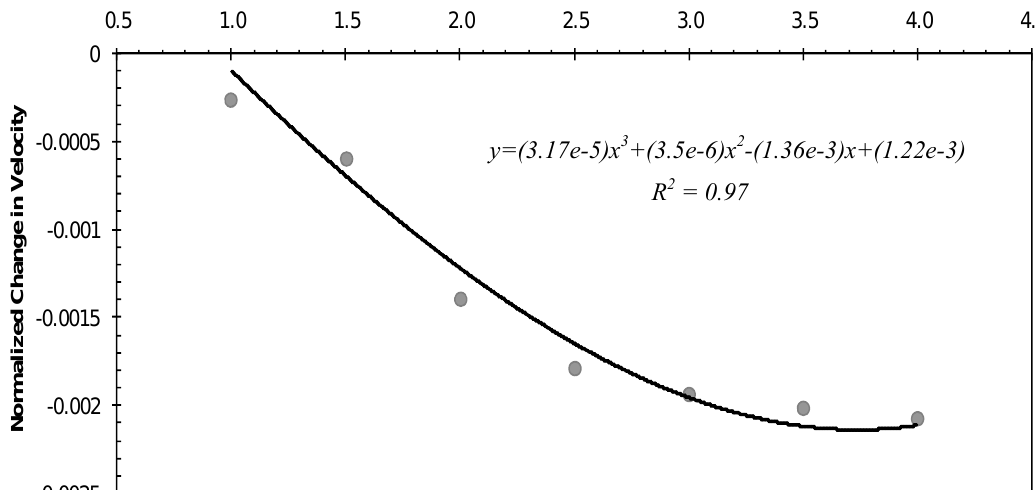
Figure 11. Normalized change in wave velocity at various H (volume %). Data is obtained from the frequency response values reported by Jakubik et al.